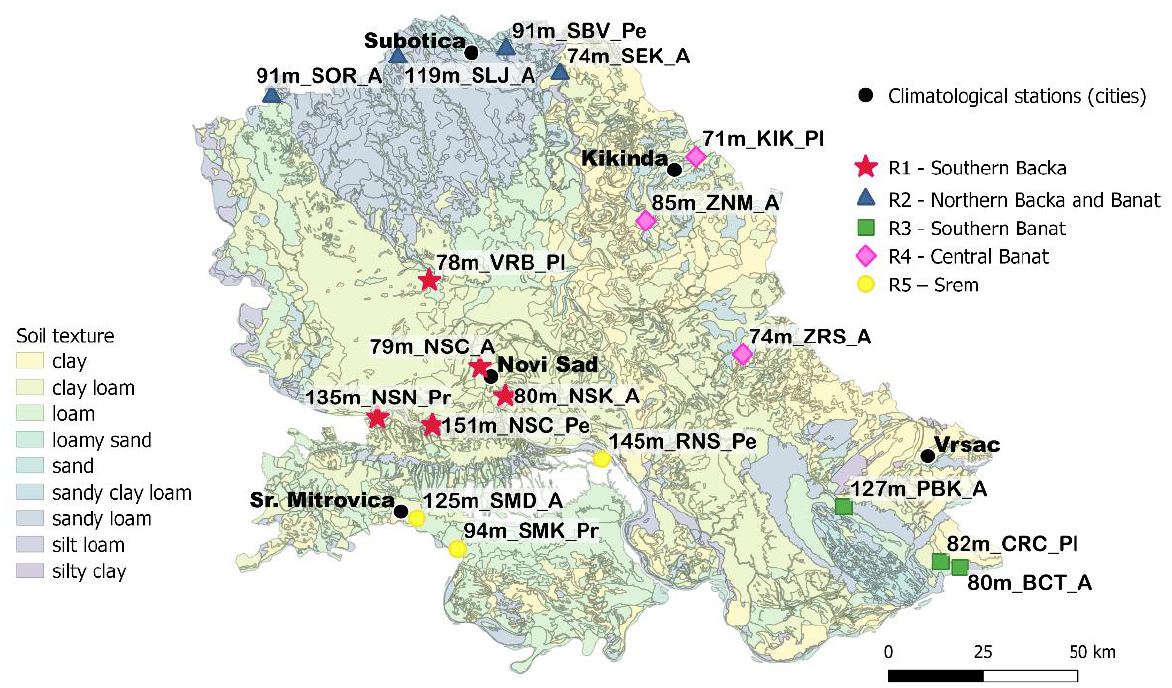
Figure 1. The map of Vojvodina soil textures and the position of AWSs (symbols) and climatological stations (other AWS details are given in Table 1).